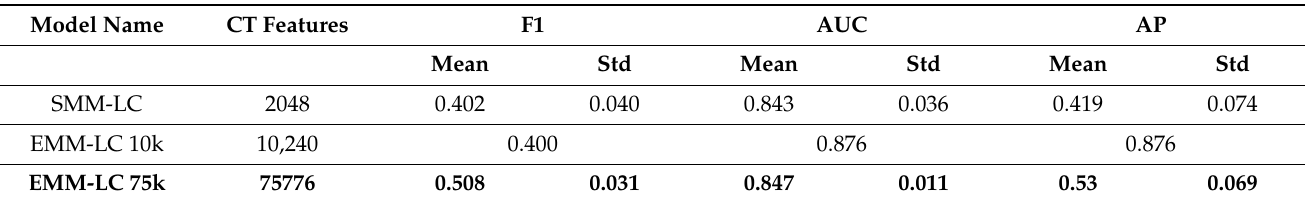
five independent tests, presenting mean and std.